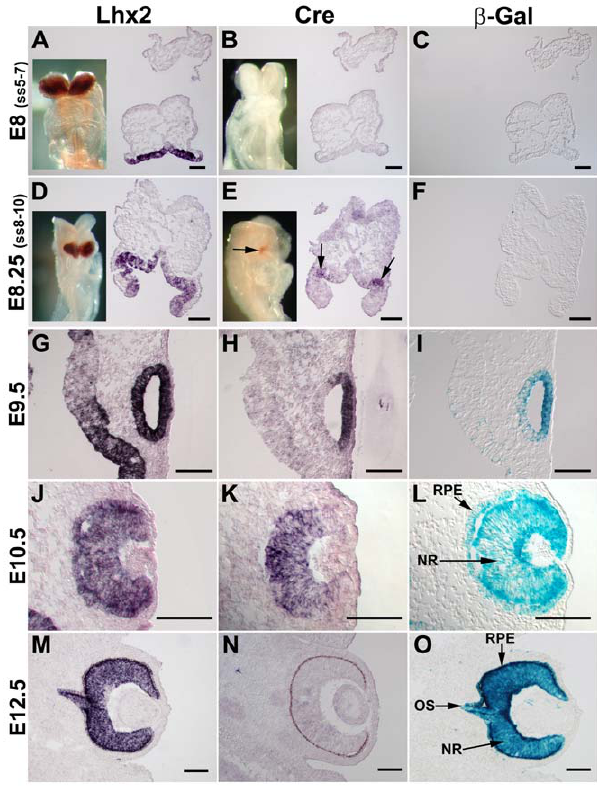
Figure 1. Cre expression in the Lhx2-Cre transgenic mouse strain defines the first progenitor cells committed to eye development in the anterior neural plate. (A–C) In situ hybridisation analyses and b -Gal staining of transversal sections of E8 embryos at somite stage 5–7 (ss5–7) to analyse Lhx2 expression (A), Cre expression (B), and b -Gal activity (C), in the anterior neural plate. In situ hybridisation analysis on whole mount embryos at the same developmental stage are inserted in A and B. (D–F) In situ hybridisation analyses and b -Gal staining of transversal sections of E8.25 (ss8–10) to determine Lhx2 expression (D), Cre expression (E), and b -Gal activity (F), in the anterior neural plate. In situ hybridisation analysis on whole mount embryos at the same developmental stage are inserted in D and E. The distinct Cre + cell population in the lateral part of the optic vesicle are indicated by arrows (E). (G–I) In situ hybridisation analyses and b -Gal staining of transversal sections of E9.5 embryos to analyse Lhx2 expression (G), Cre expression (H), and b -Gal activity (I), in the optic vesicle. (J–L) In situ hybridisation analyses and b -Gal staining of transversal sections of E10.5 embryos to analyse Lhx2 expression (J), Cre expression (K), and b -Gal activity (L), in the optic cup. (M–O) In situ hybridisation analyses and b -Gal staining of coronal sections of E12.5 embryos to analyse Lhx2 expression (M), Cre expression (N), and b -Gal activity (O), in the developing eye. NR, neural retina. RPE, retinal pigment epithelium. OS, optic stalk. Scale bars: 100 m m. doi:10.1371/journal.pone.0023387.g001 the Lhx2-Cre:ROSA26R double transgenic embryos. We were unable to detect b -Gal + cells prior to E9 including the earliest time point when Cre expression was detected (Figure 1C,F), suggesting a slight delay between Cre expression and recombina- tion of the ROSA26 locus. However, b -Gal + cells were reproduc- ibly detected in the optic vesicle at E9.5 (Figure 1I), and all cells of the neural retina, the RPE cells and the optic stalk are b -Gal + at E10.5 and E12.5 (Figure 1L,O). Thus, the cells expressing the Lhx2-Cre transgene at E8.25 in the optic pit define progenitor cells in the forebrain solely committed to become the neural part of the eye (Figure 1E).